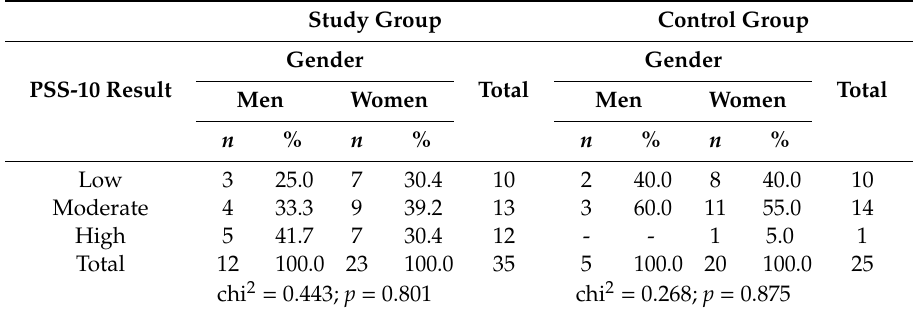
Table 5. Comparison of the frequency of low, moderate and high PSS-10 results in men and women in the study group.